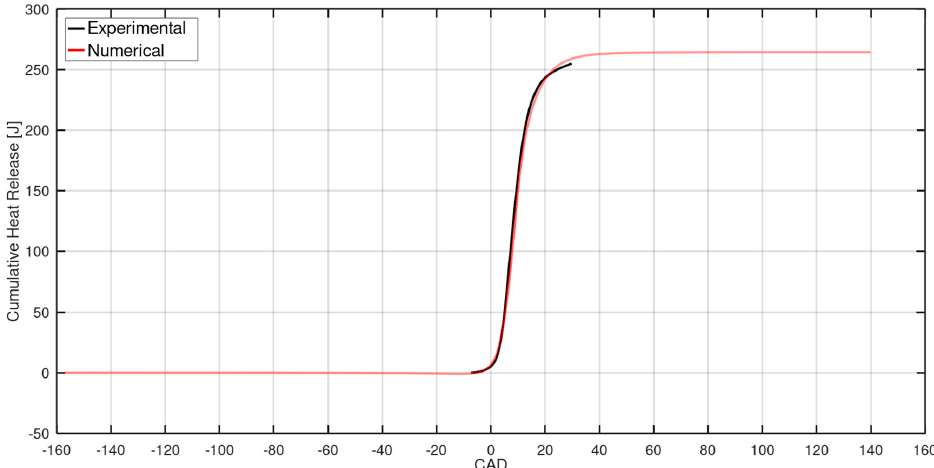
Figure 3. Comparison between experimental and numerical results in terms of cumulative heat release.